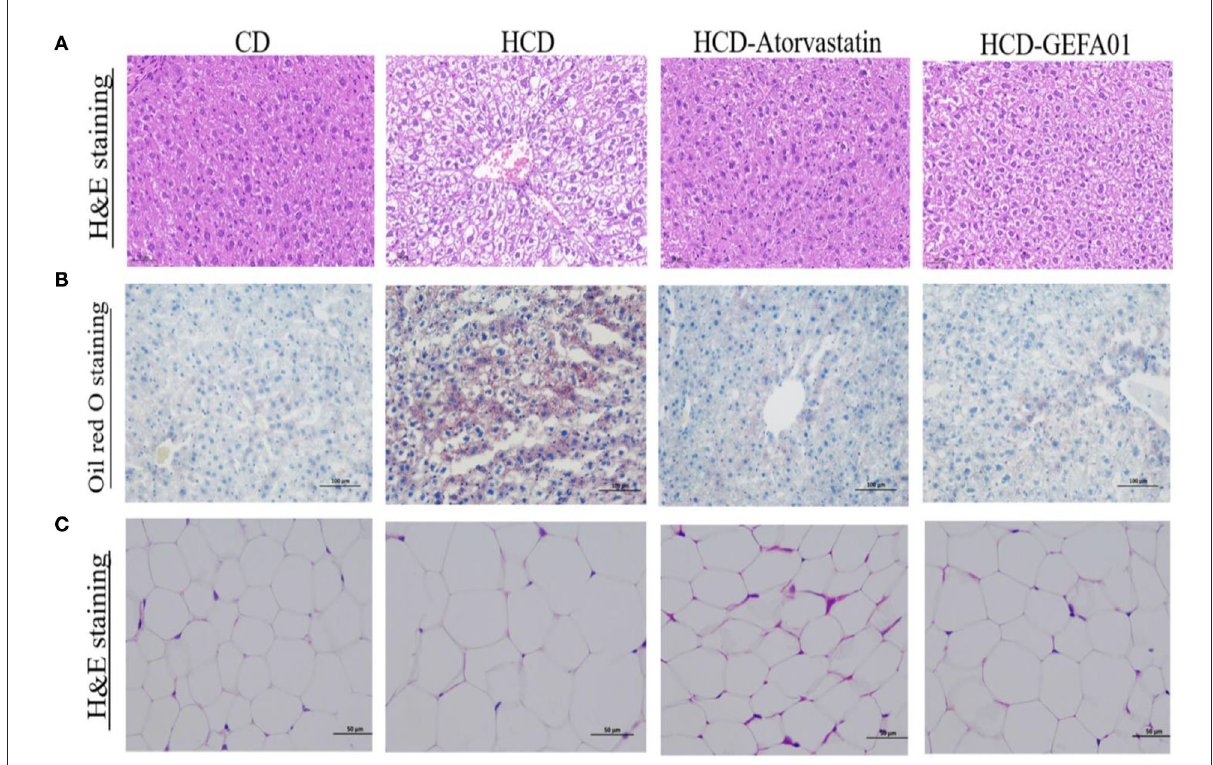
FIGURE4 E. faecium GEFA01 alleviated liver damage and steatosis in hypercholesterolemic mice. (A) Morphology analysis of liver tissues by hematoxylin and eosin (H&E) staining; (B) morphology analysis of liver tissues by Oil red O staining; and (C) morphology analysis of adipose tissues by H&E staining. n = 3 animals per group. A and C images represent the sections observed under 20 × magnification whereas B images are observed under 10 × magnification. Scale bars of 50 and 100 µ m are allotted for 20 × and 10 × magnifications,